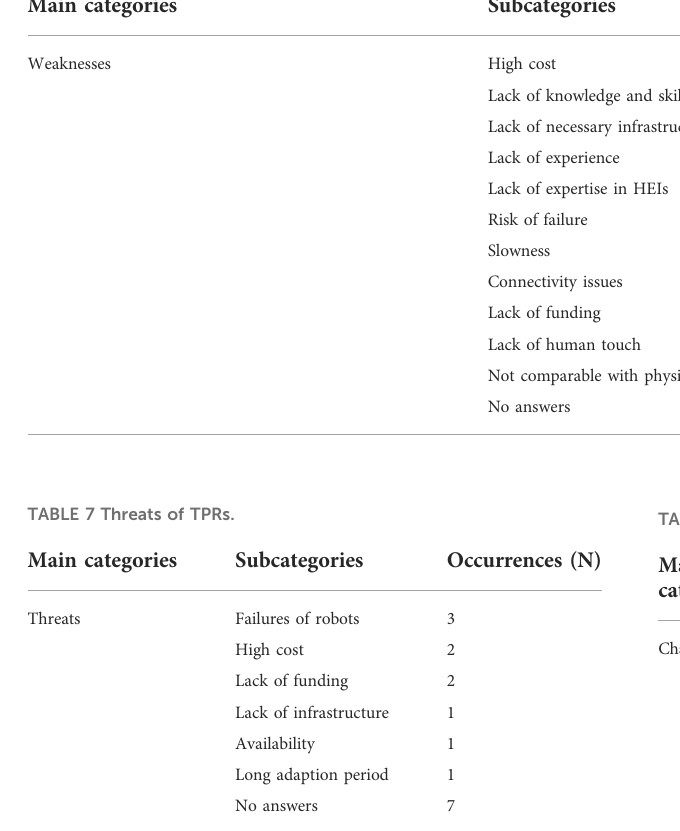
TABLE 6 Weaknesses of TPRs.